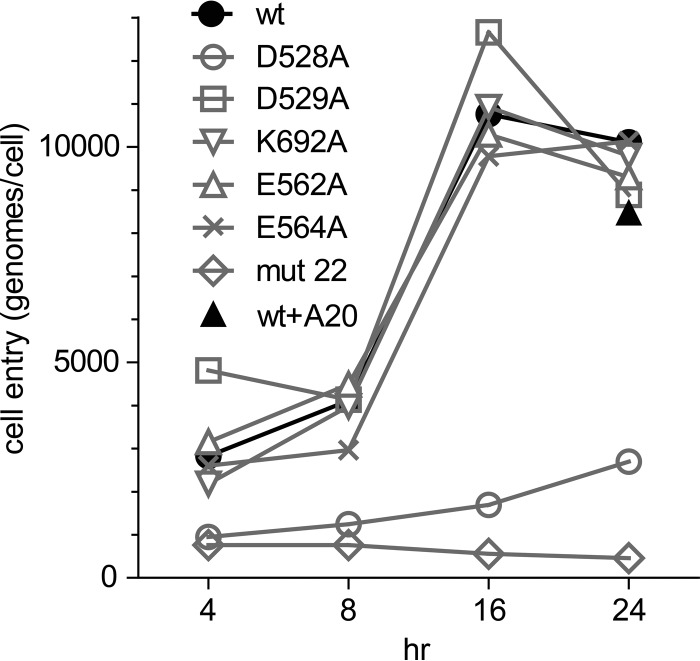
Time course of entry of wt and mutant cells. HeLa cells were infected with wt and mutant viruses at an MOI of 10,000 as described in Materials and Methods. At the indicated time points, intracellular viral DNA was collected, and the number of genomes that had entered per cell was measured by RT-PCR. Most of the mutants (gray lines) entered the cells as well as the wt. The wild-type virus bound to the A20 antibody (1:17 ratio) accumulated in cells at about the same rate as that of the wt. Two mutants (D528A and mut22) were significantly defective for cell entry. Data for each time point for each mutant represent the means of results from three separate experiments. Error bars for each time point were omitted for clarity.